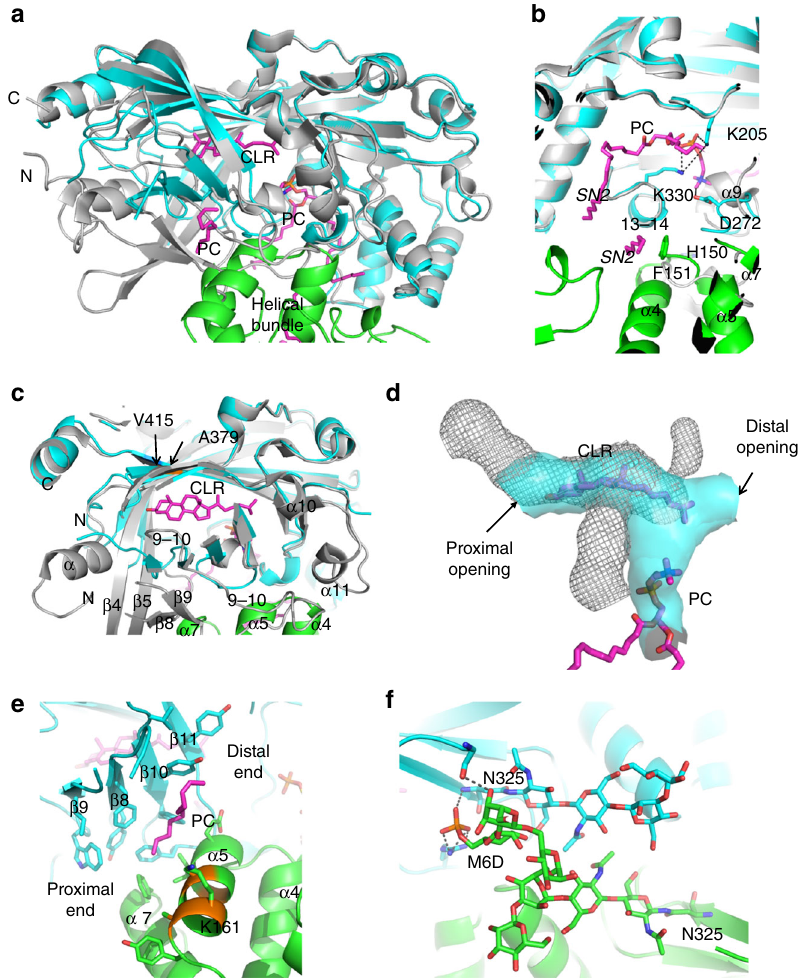
Fig. 2 Ligand binding sites and dimerization interface of LIMP-2 compared to apo LIMP-2 monomer structure. a Each subunit (cyan ribbons) of the LIMP-2 dimer has extensive conformational changes compared to those of the apo LIMP-2 monomer (gray ribbons, PDB code 4Q4F). The helical bundle of the second subunit ( α 4, α 5, and α 7 in green ribbons) is shown to indicate the location of dimer interface. b The PC-binding site at the hydrophobic tunnel. The head group of bound PC displaces the α 9 helix from its position in the apo structure, and interacts with K205, D272, and K330 (labeled). Hydrogen bonds are shown as dashes. Residues chosen for dimerization interfering mutations (H150 and F151) are indicated. c Extensive conformational changes observed surrounding the CLR-binding site. Residues V415 and A379, the equivalent residue proposed to be in the cholesterol path in SR-B1, are highlighted. Regions that are affected by CLR binding are labeled. d The hydrophobic tunnel of the apo LIMP-2 (gray mesh) is signi fi cantly different in shape and location from that of the LIMP-2 dimer (cyan solid surface) upon CLR and PC binding. e Hydrophobic cleft and the putative bound PC fragment, with contacting residues side chains shown in sticks. Equivalent residues that are important for HDL uptake by SR-BI or fatty acid or oxLDL uptake by CD36 are colored orange on the main chain. f The expansive mannose-6 glycans (M6D), P-Man9GlcNAc2 at N325, contribute to dimer interactions. Hydrogen bonds involving N- glycan are shown in chromatography (SEC) (Supplementary Fig. 3A), native and SDS gels (Supplementary Fig. 3B), and multi − angle light scattering (MALS) experiments (Supplementary Fig. 3C). Both the mono- mer and the dimer species are demonstrably stable after initial separation on SEC, and do not interconvert in solution after prolonged storage (Supplementary Fig. 3B, C). The lack of re- equilibration of these species is most likely due to the facts that lipid binding strongly favors dimer and bound lipids may not diffuse easily into aqueous solution, while the monomer is the energetically stable form of the apo protein. Indeed, phospholi- pids were detected in all dimer samples tested even after extensive detergent wash and hydrophobic interaction chromatography, while they were signi fi cantly less abundant in monomer samples (Supplementary Fig. 3D), and their relative contents in the monomer roughly track with the contents of residual dimer detected by native gels (Supplementary Fig. 3B).